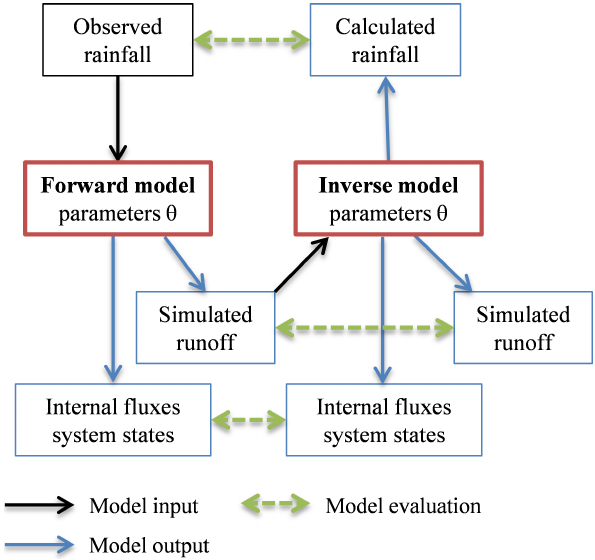
Figure 3. Setup of the virtual experiments and evaluation of the inverse model. All variables are calculated for every Monte Carlo run in which parameters θ are